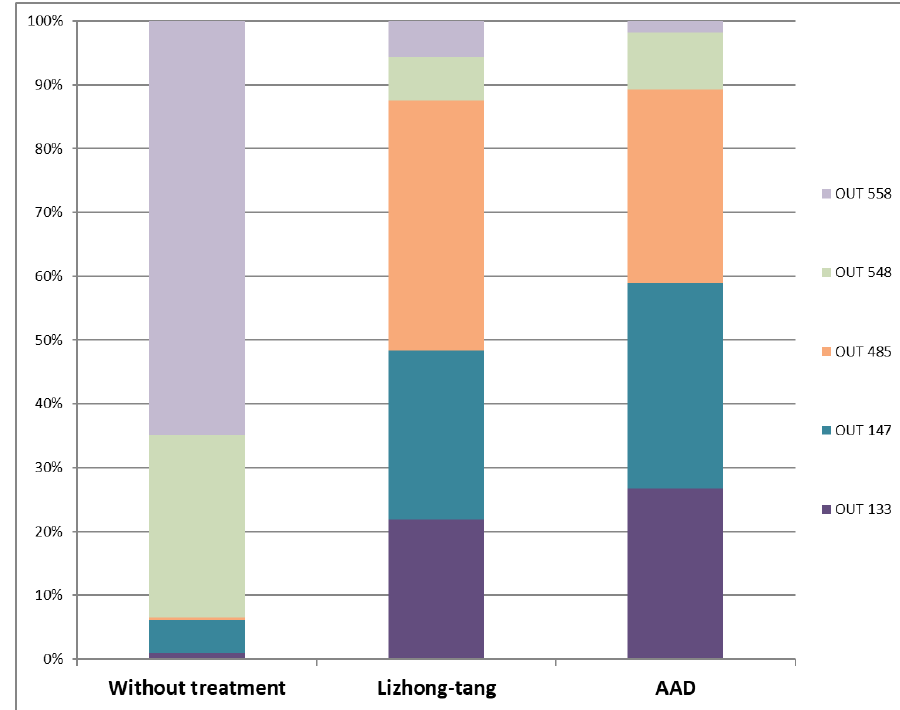
Figure 8. Comparison of operational taxonomic units (OTUs) 133, 147, 485, 548, and 558 between the normal, control, and Lizhong-tang -administered groups. After the in vivo experiment (to assess the anti-diarrheal effect of Lizhong-tang on mice in an antibiotic-associated diarrhea (AAD) model induced by means of lincomycin oral administration), DNA was isolated from the feces-containing intestinal tissues of each mouse. Microbiome analysis was carried out using the T-RFLP method.